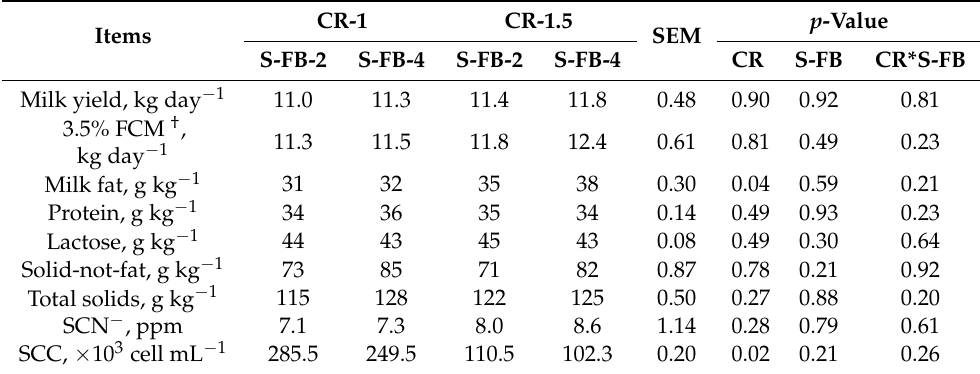
Table 6. Effect of fresh cassava root (CR) and a solid feed-block containing high sulfur (S-FB) on milk yield and its composition in lactating dairy cows. CR-1 CR-1.5 Items SEM Milk yield, kg day −